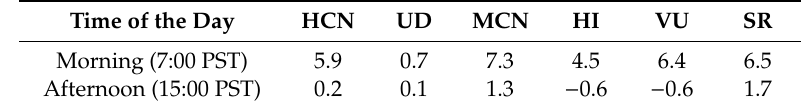
Table 4. Temperature di ff erence between simulated mean air temperature of each cluster, and the air temperature at nearest weather stations (degree